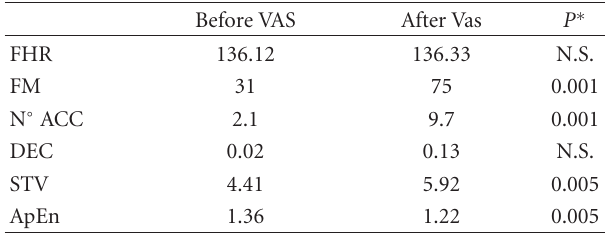
Table 3: FHR parameters before and after VAS in low-risk pregnancies ( n = 95).